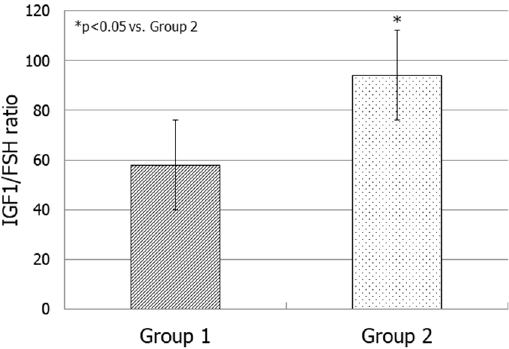
Figure 2. IGF1/FSH ratio in Group 1 and Group 2. The IGF1/FSH ratio is lower in patients with oligozoospermia (Group 1, n = 14), compared to men with normal total sperm count (Group 2, n = 45).